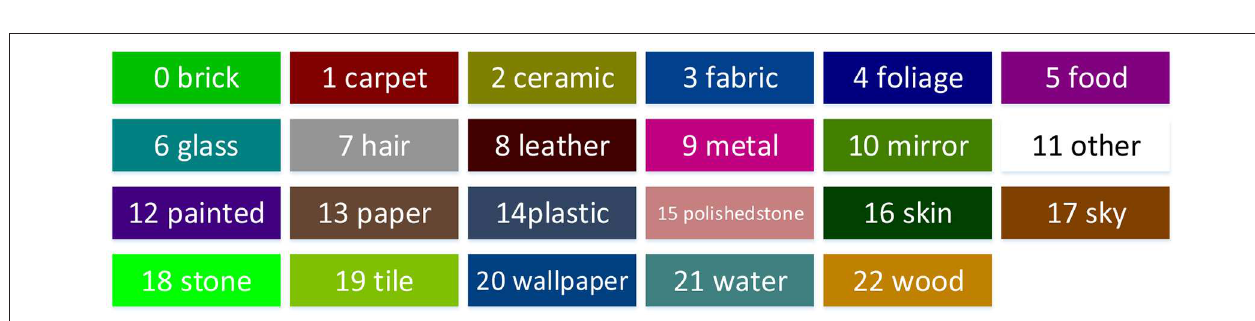
FIGURE 2 | The color palette used in this